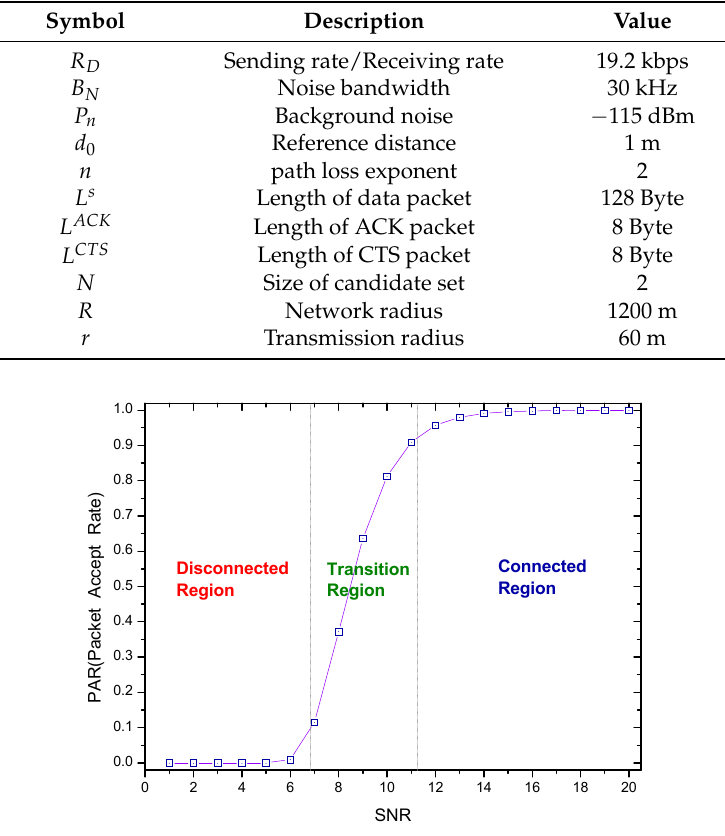
Figure 2. Packet acceptance rate and signal-to-noise ratio.